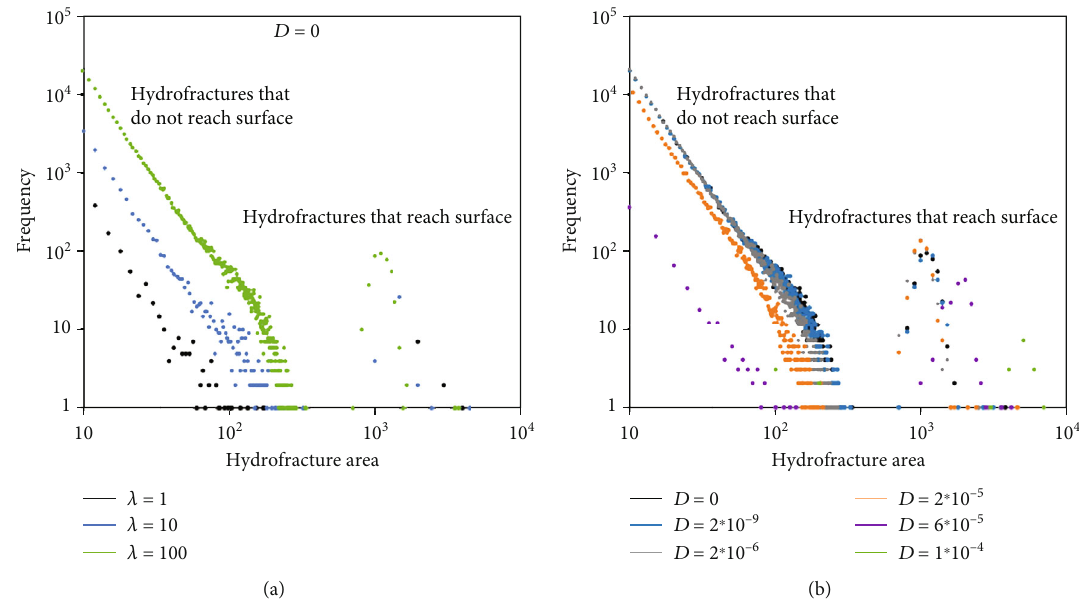
Figure 7: Absolute frequency of hydrofracture size distributions (a) for di ff erent element sizes ( λ = 1, 10, and 100m ) and D = 0 . Frequencies of hydrofractures that do not reach the surface follow a power law, whereas the distribution for hydrofractures that reach the surface is approximately log-normal. (b) Same as in (a), but for di ff erent di ff usion coe ffi cients. An element size of λ = 100 was used for all simulations. Power-law fi ts for hydrofractures not reaching the surface for both (a) and (b) are given in Table 3. Table 3: Data and power-law fi ts of data shown in Figure